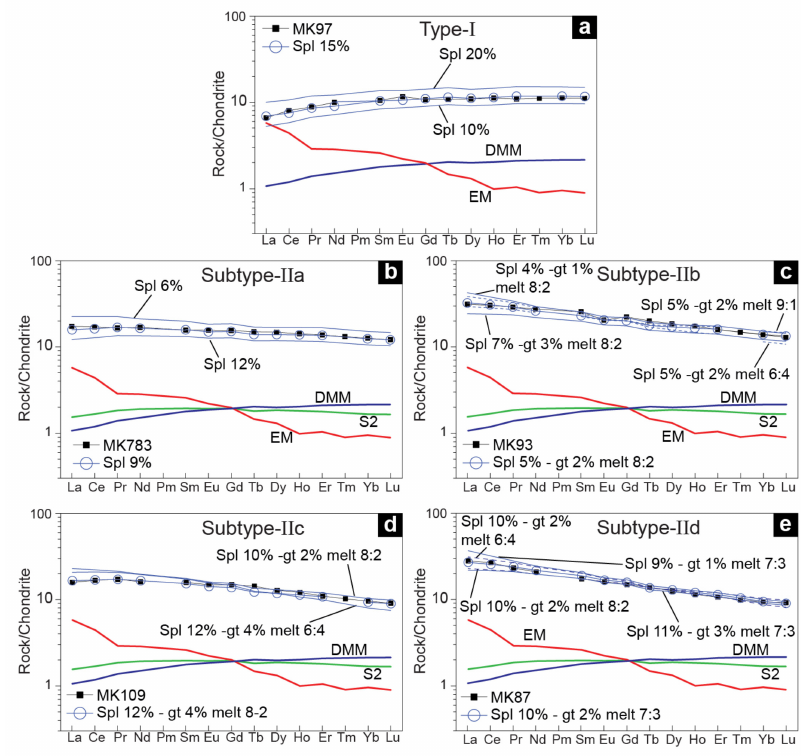
Figure 16. Calculated chondrite-normalized [73] rare earth element (REE) liquid composition for parental melts derived from di ff erent mantle sources, assuming various degrees of non-modal batch partial melting: ( a ) Type-I; ( b ) Type-IIa; ( c ) Type-IIb; ( d ) Type-IId; ( e ) Type-IIe. Abbreviations: EM: enriched mantle source (from Lustrino et al. [89]); DMM: depleted MORB mantle [82]; S2: